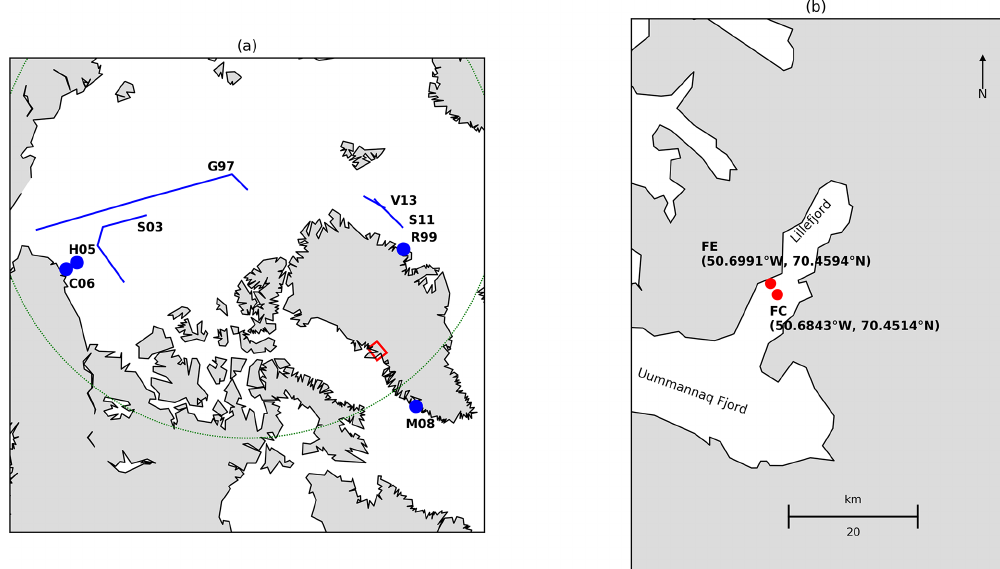
Figure 1. (a) Locations where microbial metabolism has been measured in the water column under sea ice (minimum sea ice cover 80%). Abbreviations follow Table 1. Positions of points and transects are approximate and are based on maps in the corresponding publications. The Arctic Circle is marked in green and the red box shows the location of Lillefjord, west Greenland. (b) Location of the fjord edge (FE) and fjord centre (FC) study sites. Coastline data are from https://www.soest.hawaii.edu/pwessel/gshhg/ (last access: 17 April 2020, Wessel and Smith,